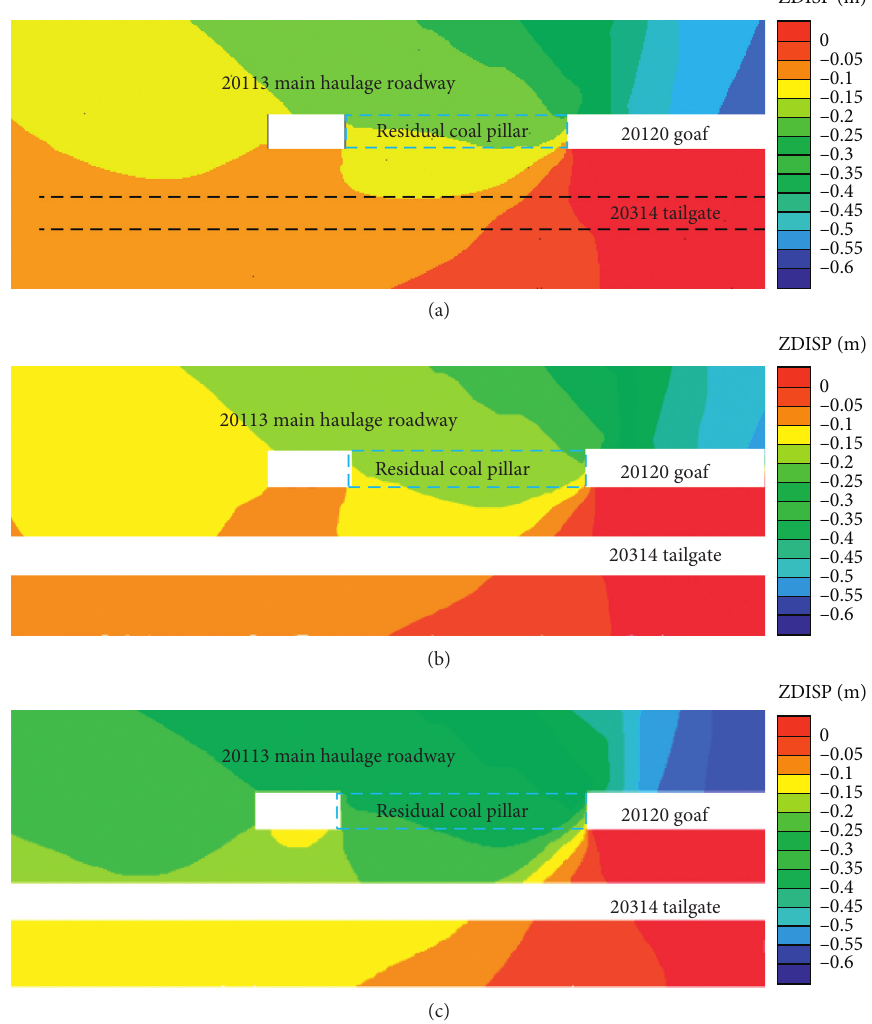
Figure 13: Displacement variation of the roof of the 20314 auxiliary haulage roadway (parallel to the axis section of the roadway): (a) 2-2 upper coal seam excavation; (b) 20314 tailgate excavation; (c) 20314 panel